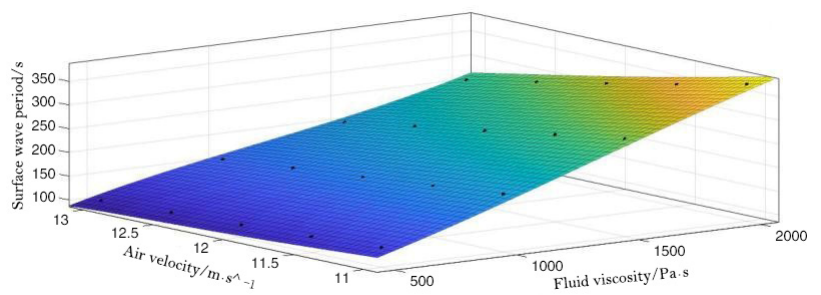
Figure 14. Fitting points and the fitting surface between gas jet velocity, dimethyl silicone oil viscosity and surface wave period.